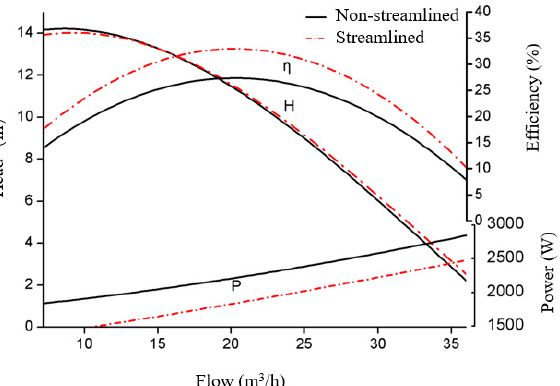
Figure 18. Pump performances comparing streamlined cutter head with non-streamlined cutter head.